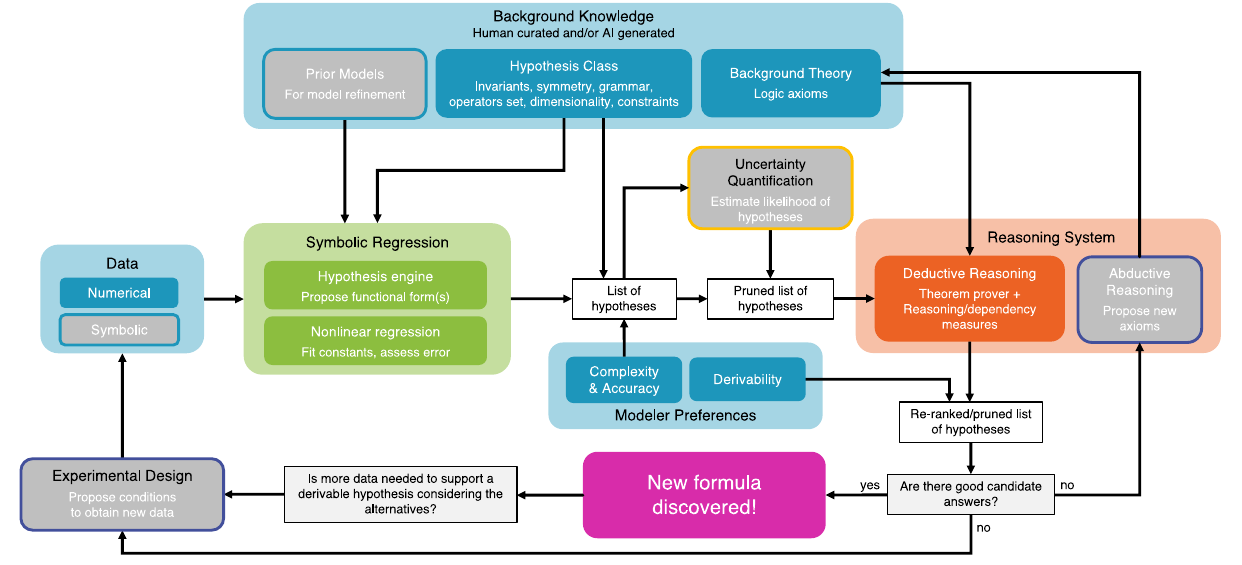
Fig. 3 | System overview. Colored components correspond to our system, and gray components indicate standard techniques for scienti fi c discovery (human- driven or arti fi cial) that have not been integrated into the current system. The colors match the respective components of the discovery cycle of Fig. 2. The